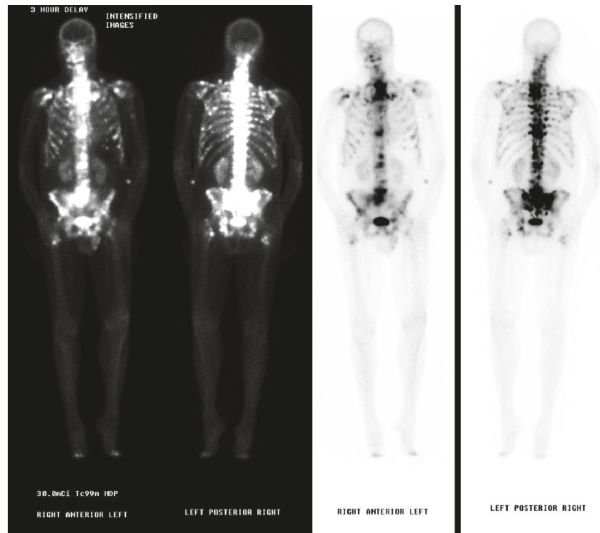
Figure 5: Whole-body bone scan showing multiple bony metastatic lesions throughout the skeleton.